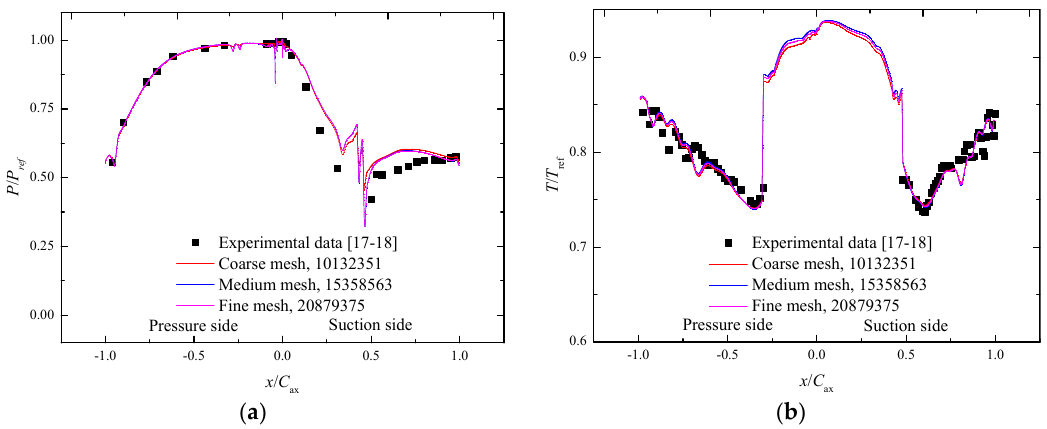
Figure 4. Comparisons between numerical results and experimental data at the midspan ( z = 0 mm). ( a ) pressure comparison ( P ref = 285.13 kPa), ( b ) temperature comparison ( T ref = 701 K).